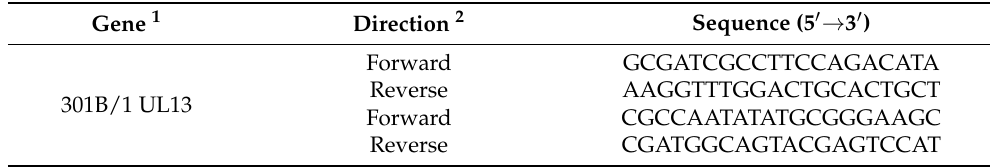
Table 2. Primers used for